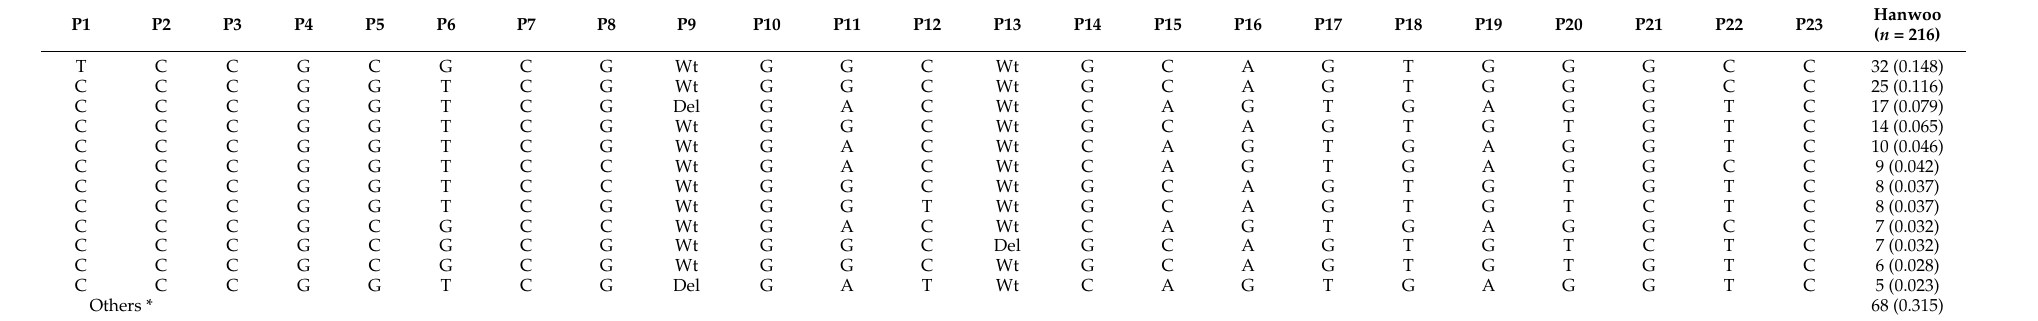
Table 5. Haplotype frequencies of bovine IFITM3 gene polymorphisms in Hanwoo.